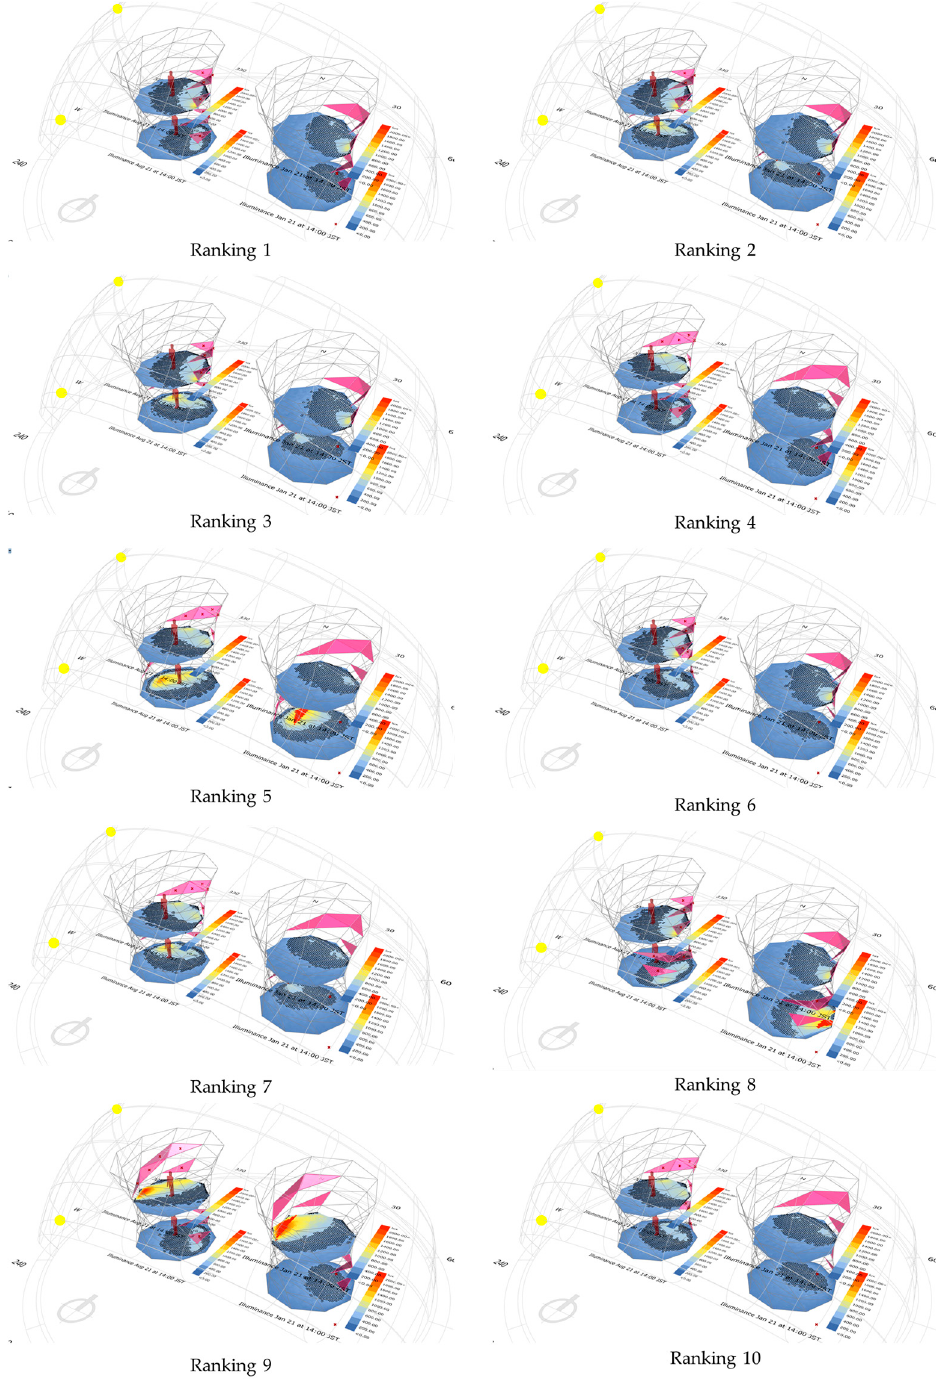
Figure 16. Best design solution related to daylight based on fitness function calculation.